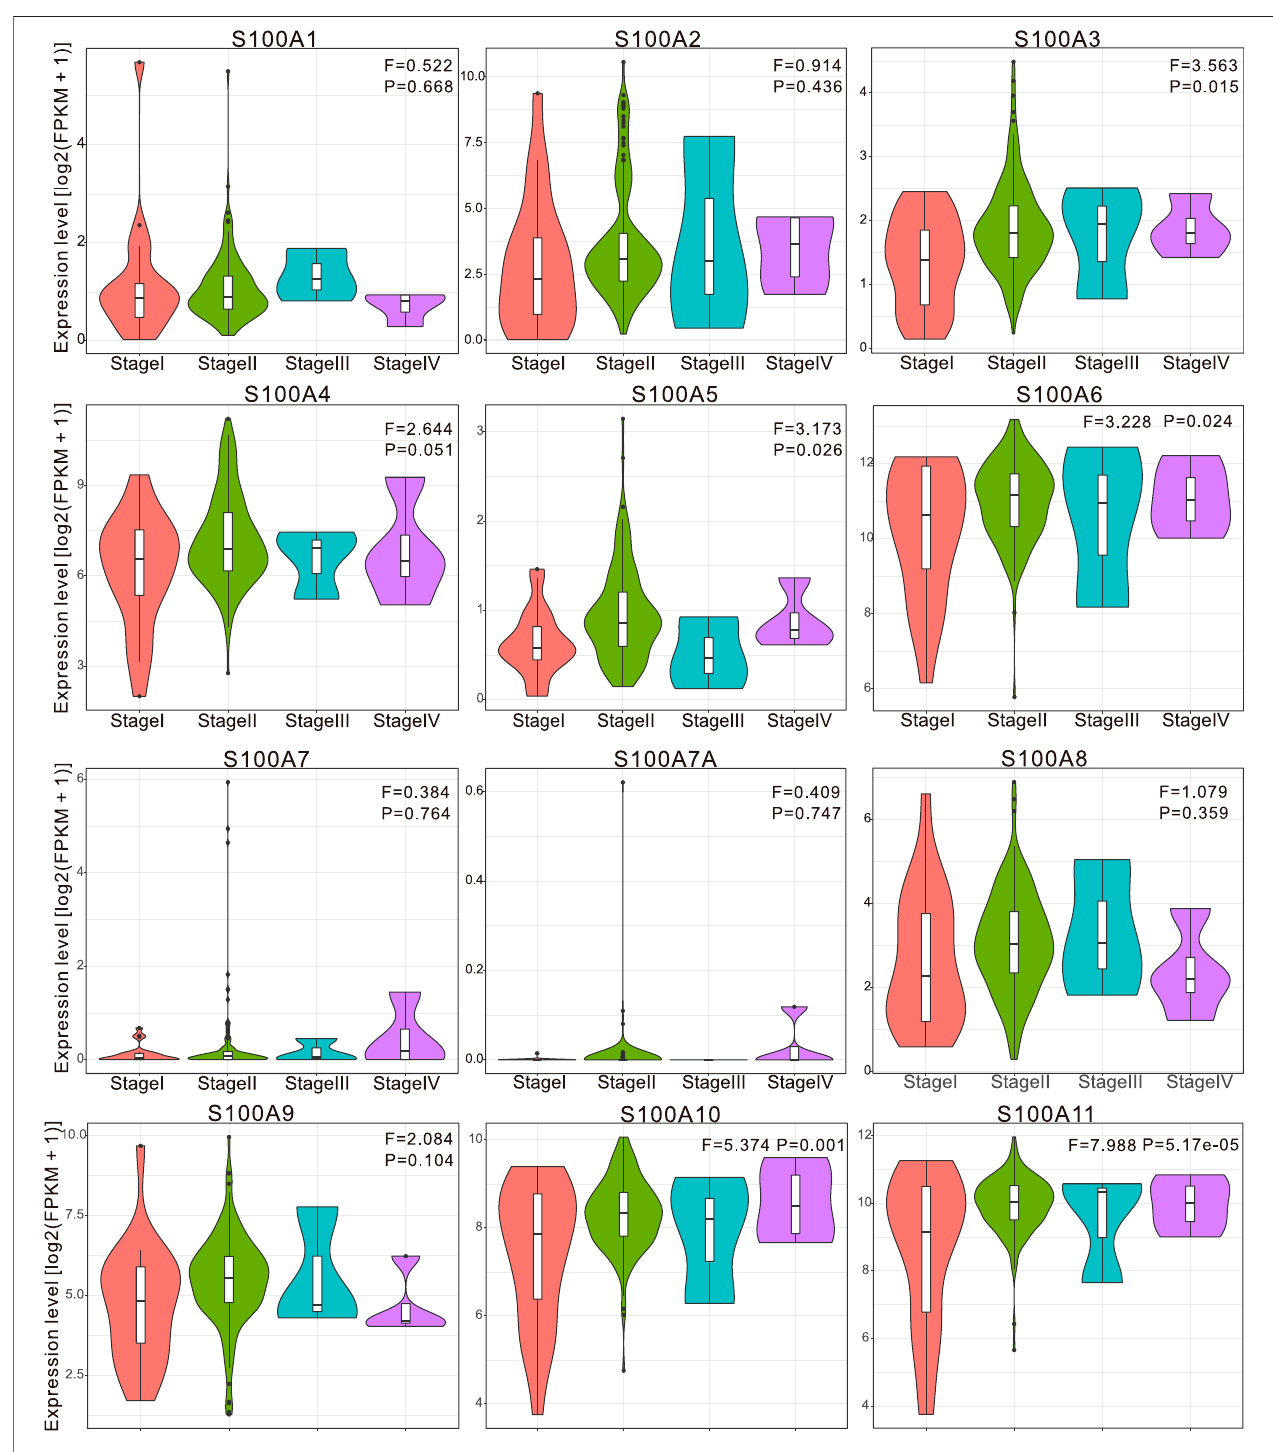
FIGURE 4 | Violin plot demonstrated the correlation between S100s transcription level and tumor stages in patients with PAAD (calculated data form TCGA- PAAD). The difference of individual S100s gene expression in each stage was analyzed by one-way ANOVA, in which Pr ( > F) < 0.05 was considered to be statistically signi fi cant.Thenumberofpancreaticcancersamplesat eachtumor stagewas21casesinstageI,146instageII,3instageIII,and 4instageIV. Abbreviation: Fvalue, the statistical value of F test; Pr ( > F), p -value.